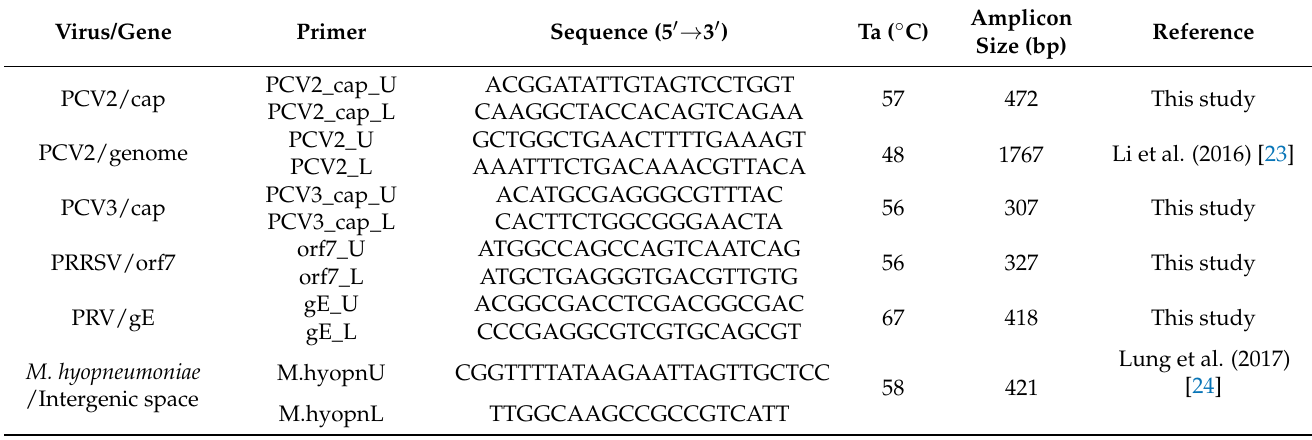
Table 1. Primers for pathogen gene